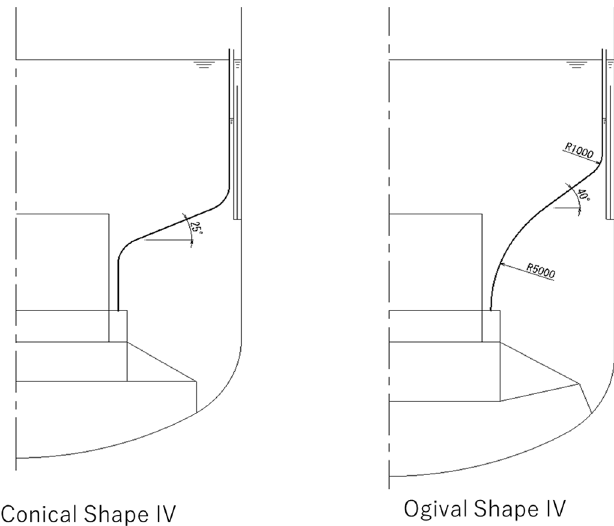
Fig. 3. IV shape to improve seismic